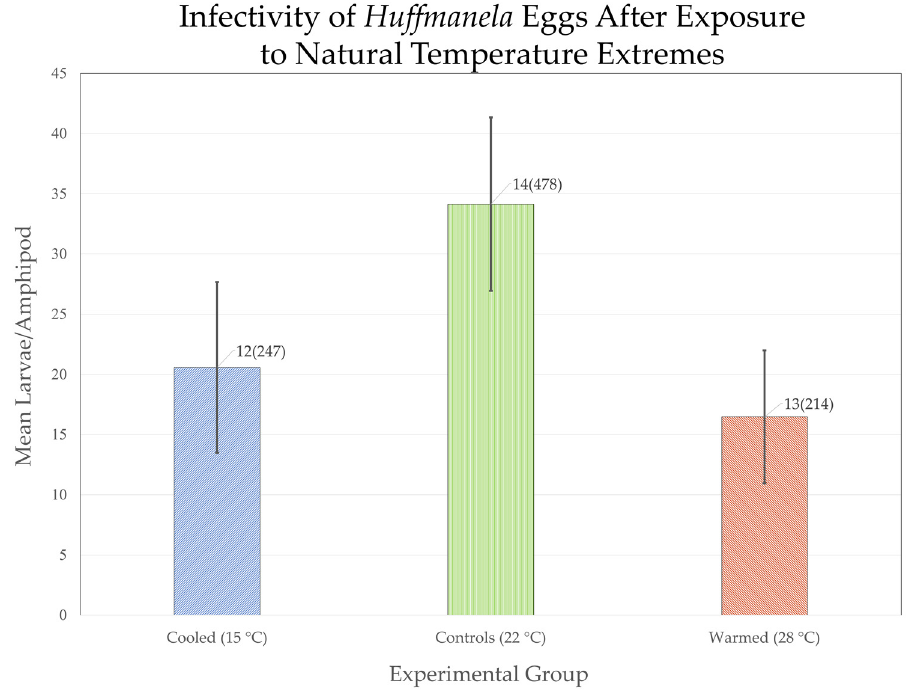
◦ ◦ C and 28 C) for 16 h on the ability of thermally ◦ C);